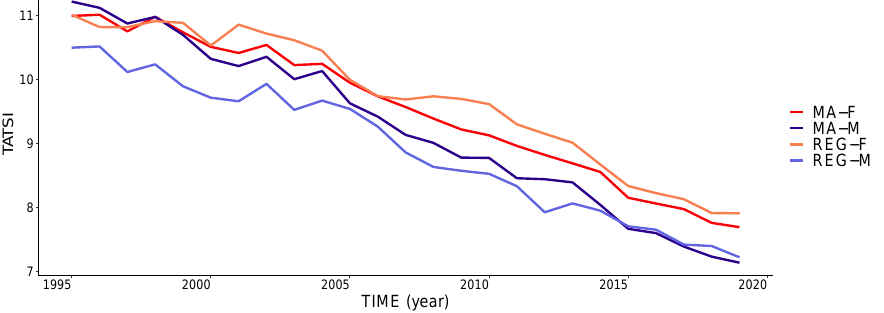
Figure A4. TATSI index for Italian female (F) and male (M) population aged 65 from 1995 to 2019 across macroareas (MA, NUTS-1 level) and regions (REG, NUTS-2 level). Source: author’s own elaboration on data from